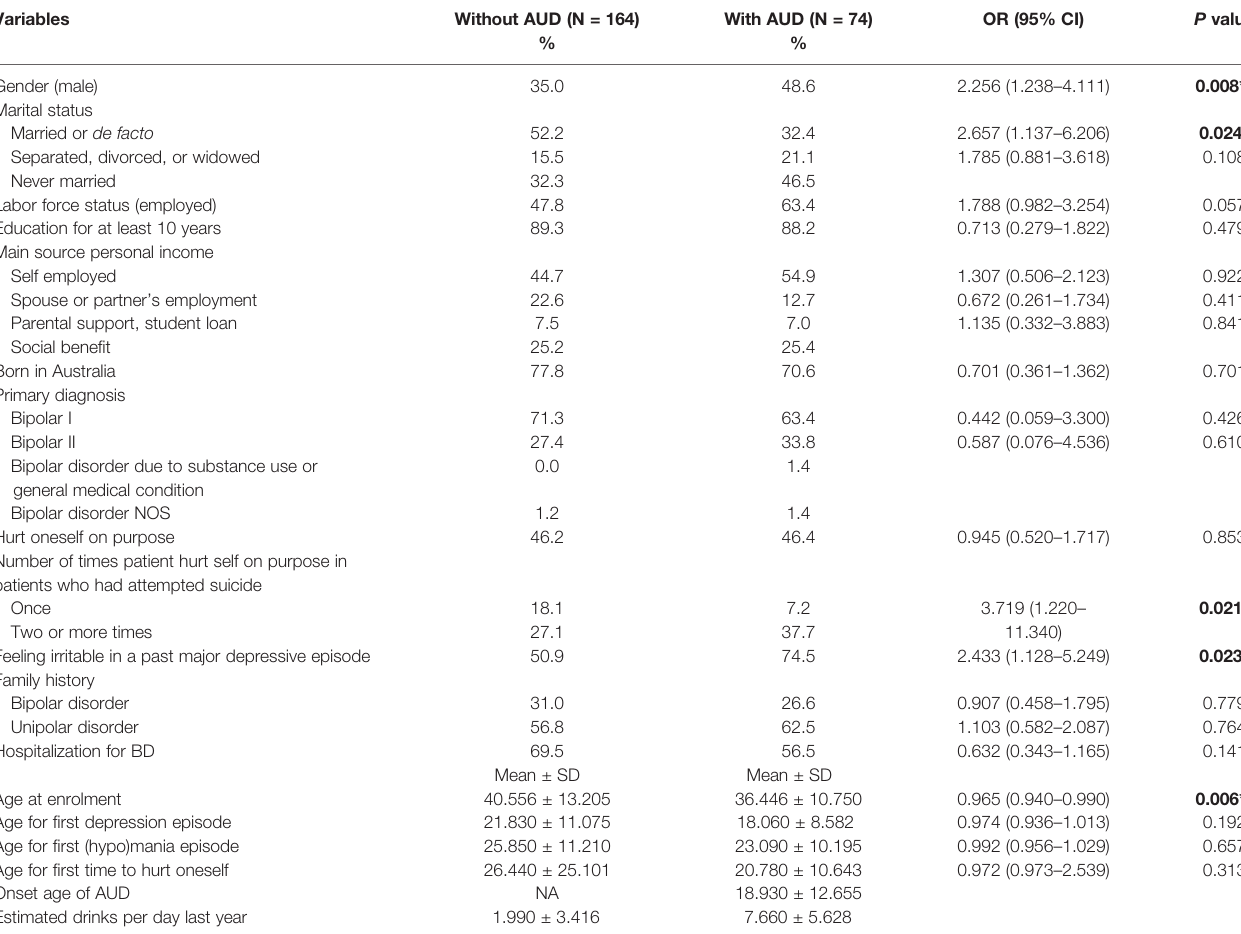
TABLE 1 | Logistic regression analysis of potential risk factors in sociodemographic and clinical features of bipolar patients after adjusting for age and gender.